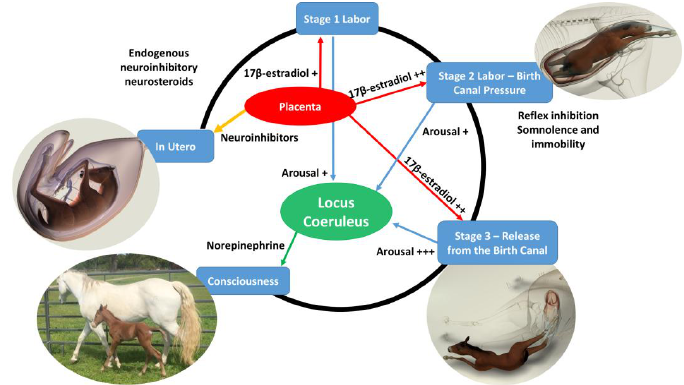
Figure 2. Illustration of the proposed influences associated with the transition of consciousness from intrauterine to extrauterine life. While in utero, the fetal foal remains in a sleep-like state of consciousness, which acts to protect the mare from movements of long limbs of foals weighing 80– 120 lbs (37.2–54.4 kg) at birth. This neuroinhibited state is maintained in mammals through high circulating and cerebral concentrations of adenosine, progesterone and its related neuroactive steroids allopregnanolone and pregnanolone, as well as prostaglandin D2 and a placental neuroinhibitory peptide, all acting together with warmth, buoyancy, and cushioned tactile stimulation [2–6]. At the onset of stage-1 labor the fetus comes under the stimulation of 17β-estradiol, which continues through stages 2 and 3 affecting the locus coeruleus. The locus coeruleus produces large amounts of norepinephrine, which causes the transition to consciousness at birth. During stage- 2 labor, the arousal stimulation is overridden by thoracic pressure that induces squeeze-induced somnolence and immobility while in the narrow birth canal. When the fetus exits the birth canal, the squeeze pressure is released and full stimulation from the priming of 17β-estradiol occurs. The foal transitions to full consciousness and mobility shortly after delivery, which is essential for survival as a prey animal. Animals 2017 , 7 , 69